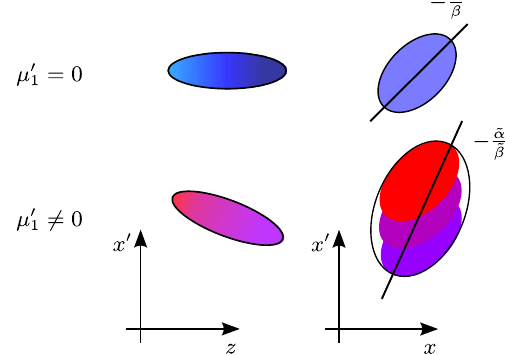
FIG. 3. Sketch of the optical mismatch introduced through μ 0 1 . The projected phase space ellipse is rotated according to Eqs. (10) and (11). Note that in this example β ¼